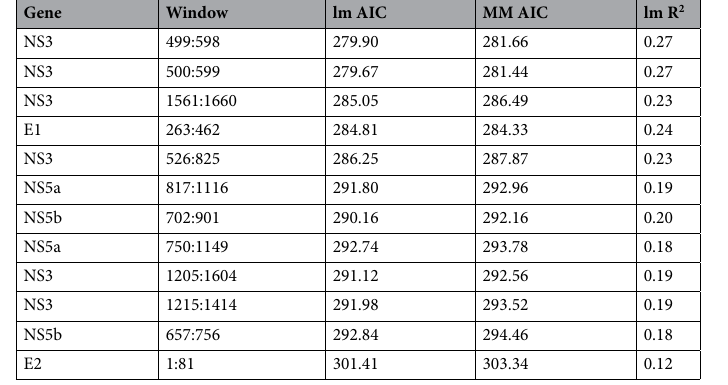
Table 2. Akaike information criterions for models predicting time from diversity. Shown are the linear mixed model AICs (MM AIC), the linear model AIC (lm AIC), and the linear model R 2 values (lm R 2 ). The models with the best AICs are shown among each region. There were additional overlapping regions within each 100, 200, 300, 400, and 500 bp window containing similar AIC values, however unique regions are preferentially displayed.